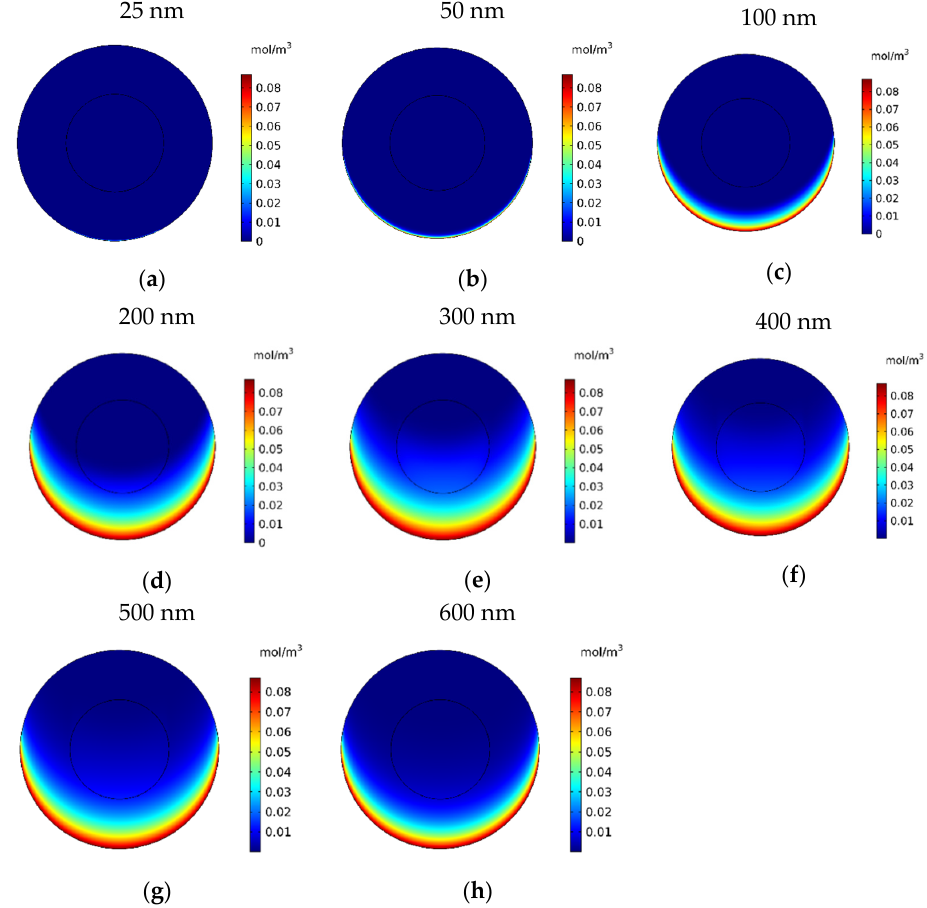
Figure 12. Contours of the free drug concentration ( C F ) after 60 min of treatment with magnetically controlled IP chemotherapy for different nanoparticle radius: ( a ) 25 nm, ( b ) 50 nm, ( c ) 100 nm, ( d )